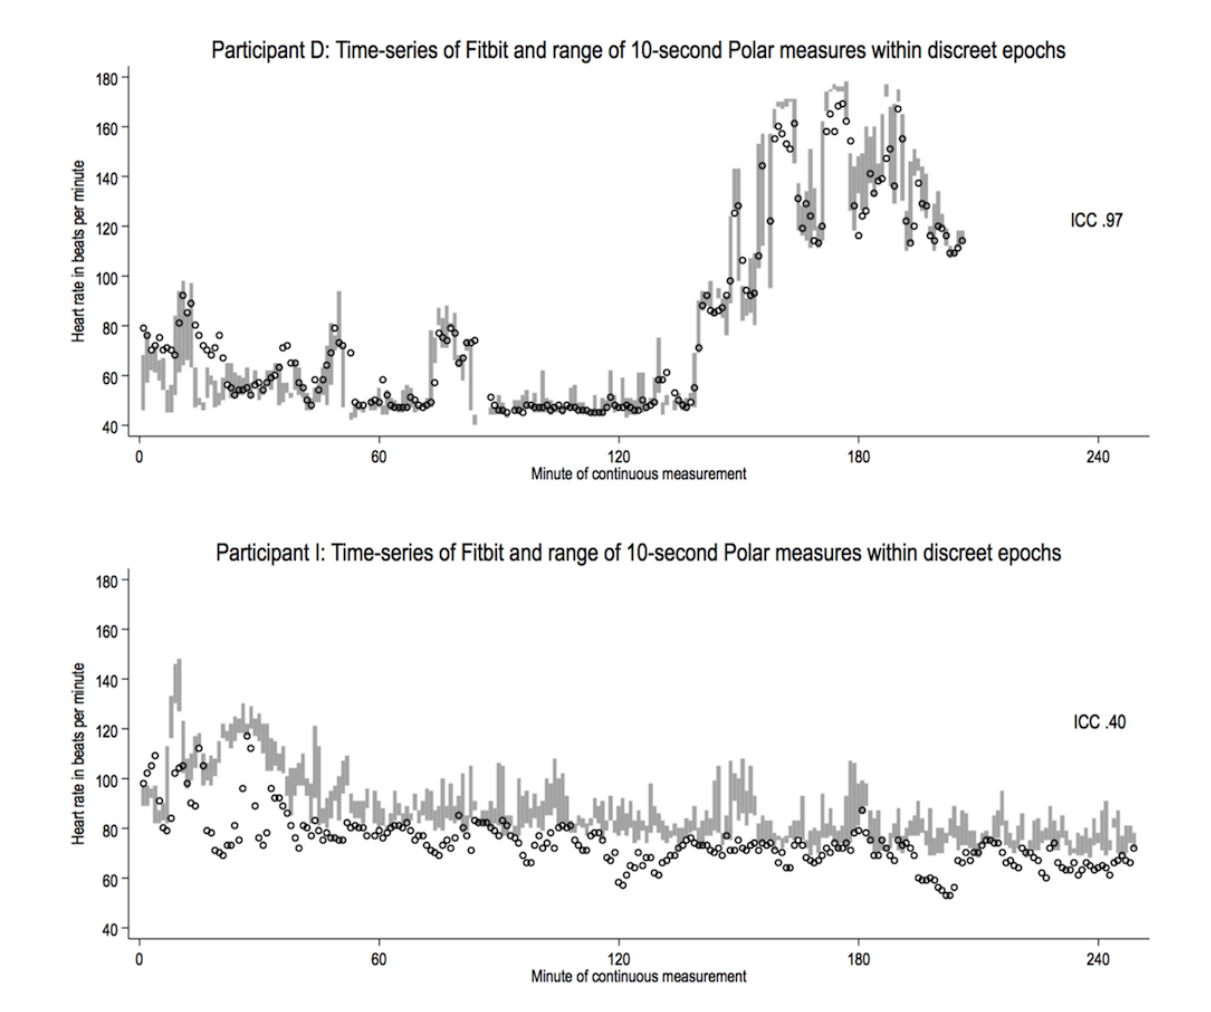
Figure 1. Time-series of Fitbit 1-min measures (circles) and Polar 1-min ranges (gray bars) estimating heart rate in beats per minute for participants D and